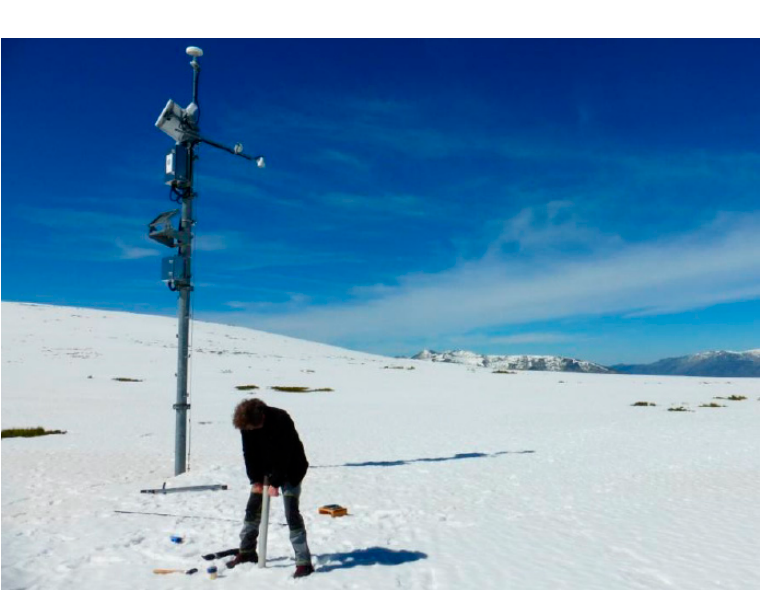
Figure 4. TNM and on-site manual sampling for the snow pole